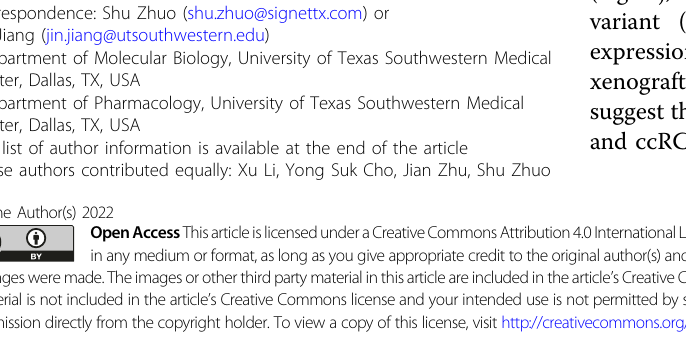
(Fig. 1j, m). In contrast, TEAD-binding-de fi cient